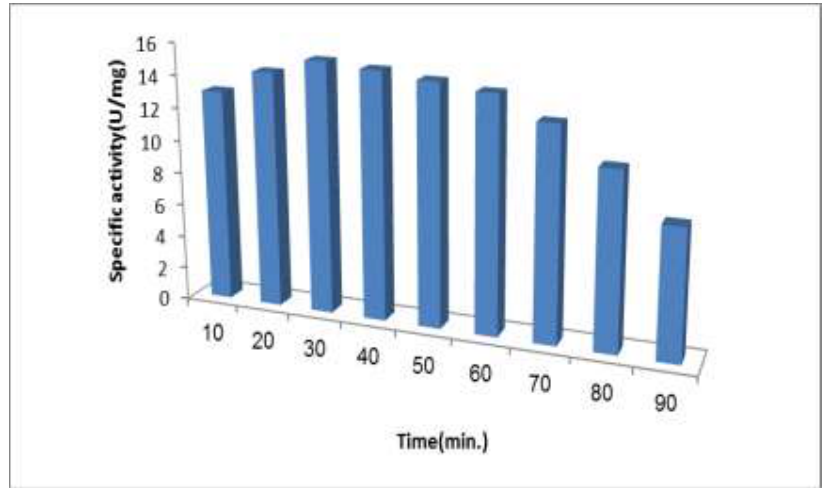
Figure 4: Influence of incubation time on Pullulanase activity.